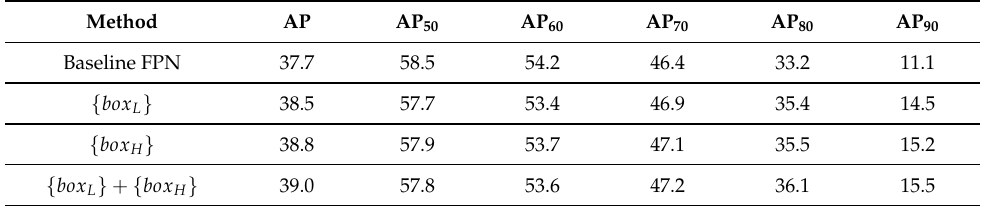
Table 1. Results of selecting different training samples for IoU regression. Quantitative results show that our H+L-Sampling strategy is effective to resolve the misalignment